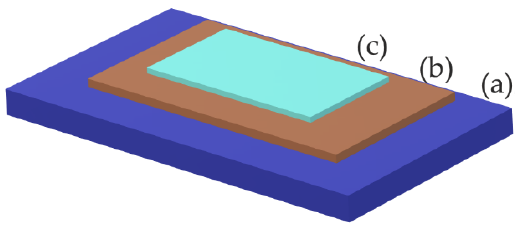
Figure 16. Structure of a BFO thin film ( a ) substrate; ( b ) buffer layer; ( c ) Bismuth ferrite.